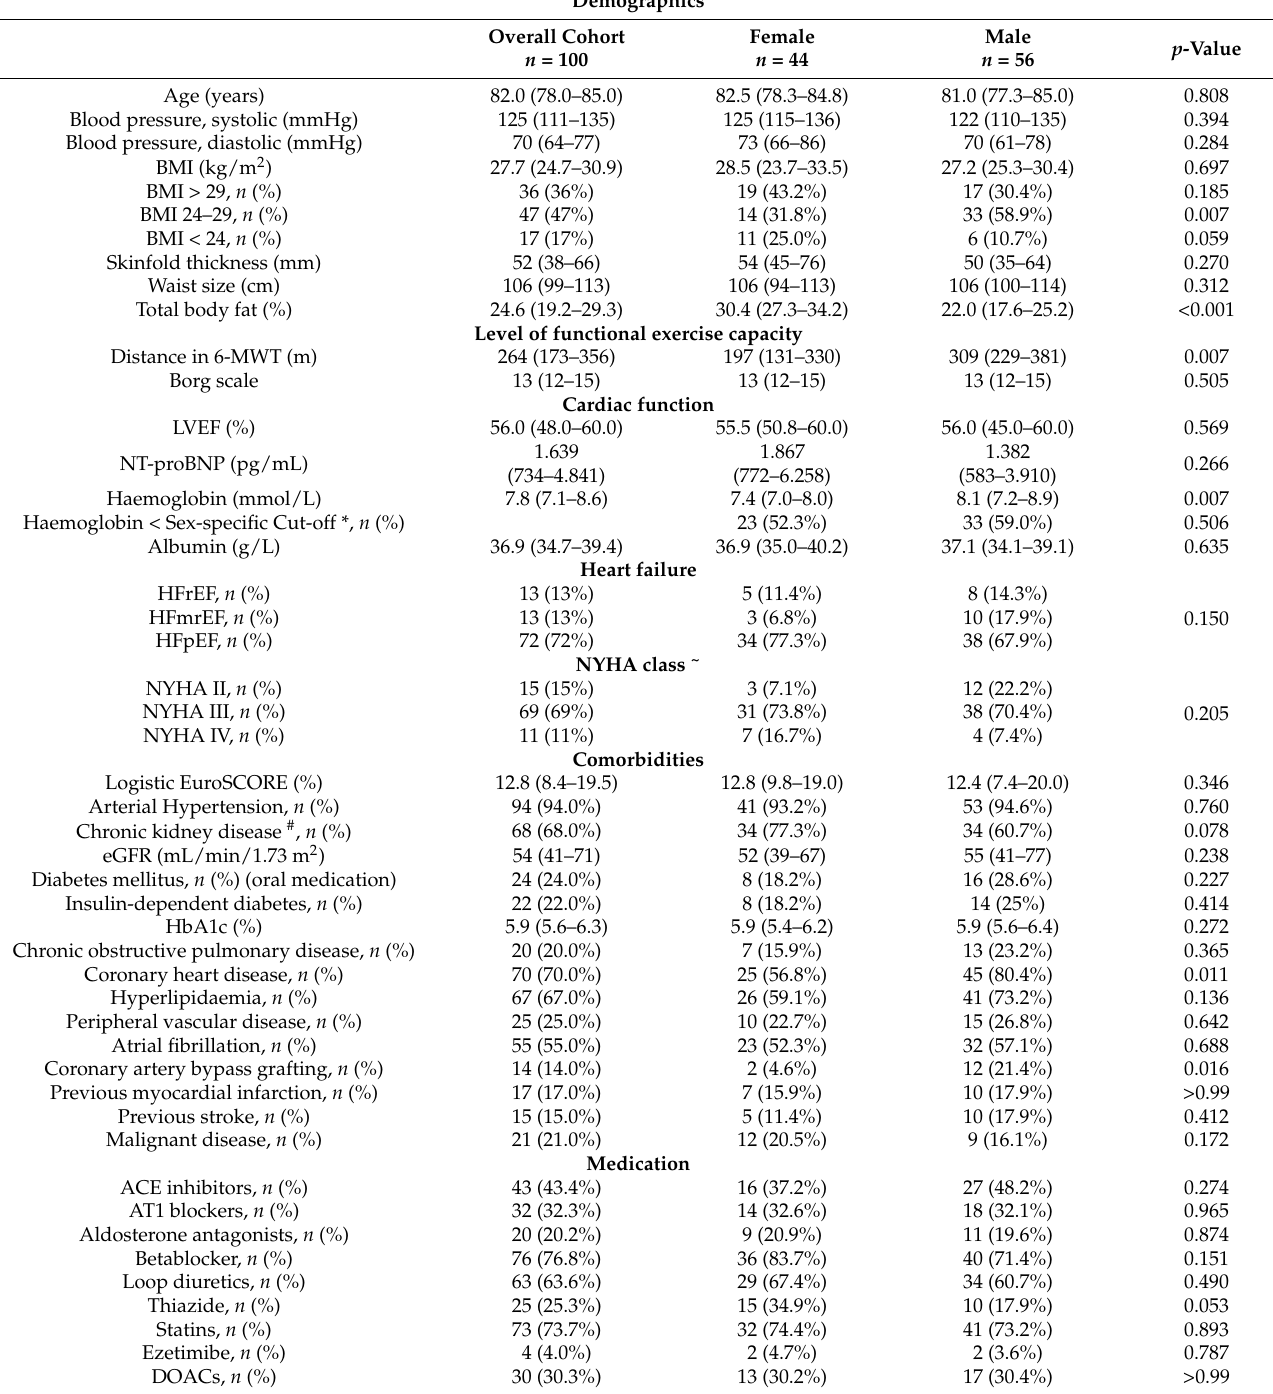
Table 1. Baseline characteristics and